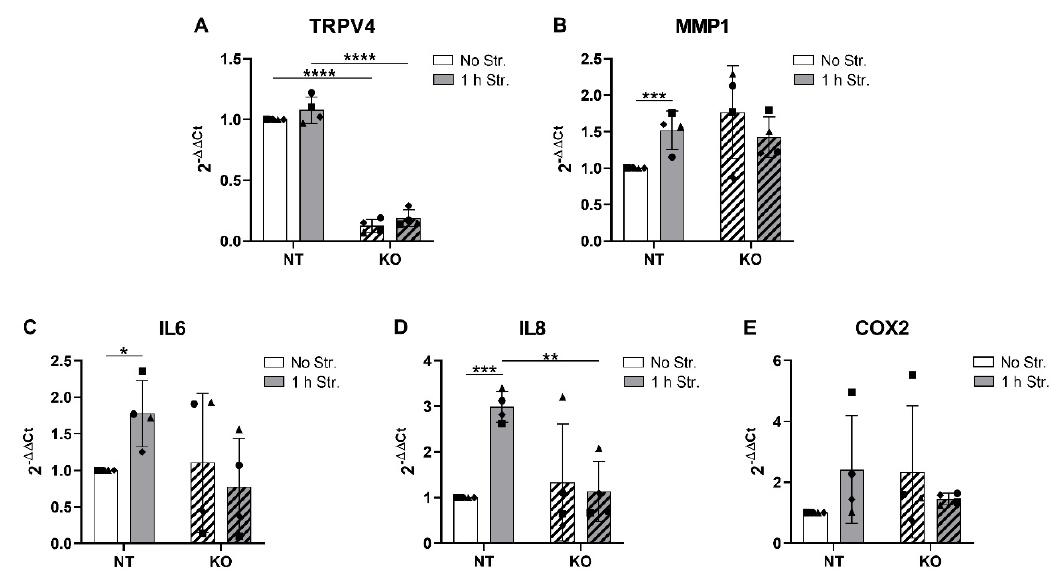
Figure 6. Gene expression of ( A ) TRPV4; ( B ) MMP1; and ( C – E ) pro-inflammatory mediators in the CRISPR-Cas9-transduced non-targeting control (NT, non-hatched bars) and the TRPV4 knockout (KO, hatched bars) cells, immediately after no (white bars) or 1 h (grey bars) of cyclic stretching at 20% strain and 1 Hz. n = 4 donors; mean ± SD; * p < 0.05, ** p < 0.01, *** p < 0.001, **** p < 0.0001.